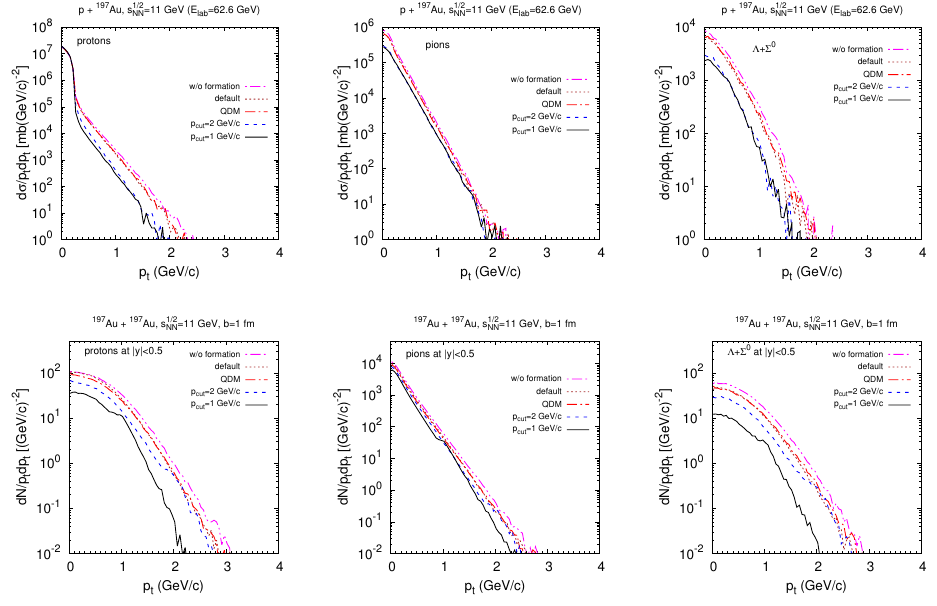
Figure 8. Transverse momentum spectra of protons, pions and neutral hyperons produced in minimum bias p + Au collisions and central ( b = 1 fm) Au + Au collisions at show calculations with different prescriptions for hadron formation (line notations are the same as in Figure 5). For the case of Au + Au collisions, the rapidity cut | y | < 0.5 has being applied for the